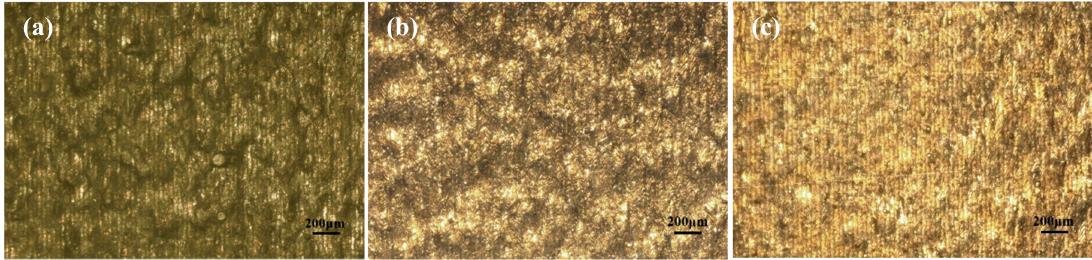
Figure 3. The top macro-morphology via different exposure times: ( a ) 100 µ s; ( b ) 160 µ s; and ( c ) 220 µ s.